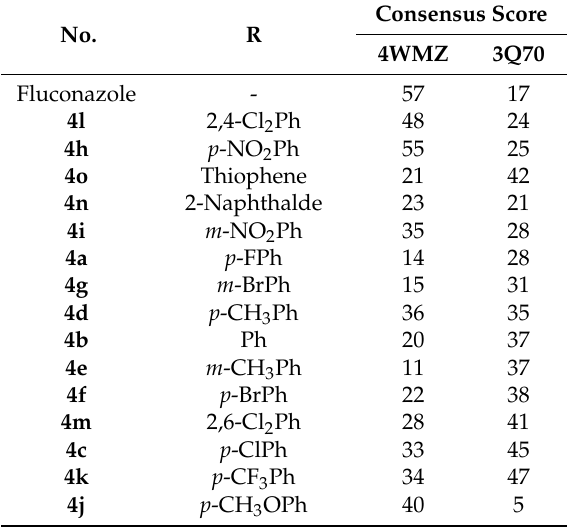
Table 3. Molecular modeling consensus score for the tested compounds and Fluconzole.